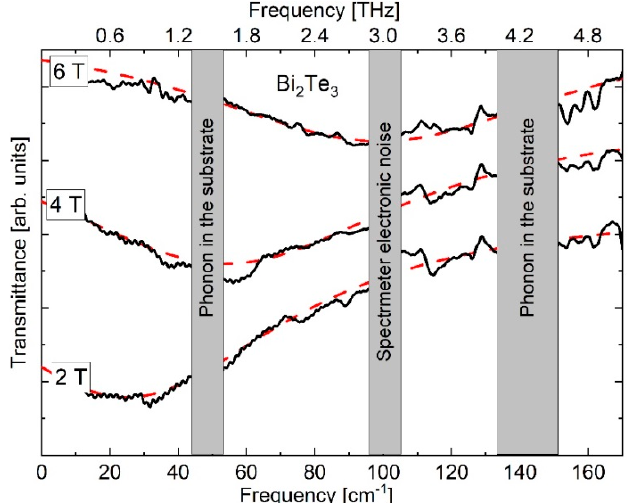
Figure 3. Examples of Lorentzian fits of the transmission spectra from Figure 1 for a few magnetic- field strengths as indicated. The raw experimental data are smoothed, using a Savitzki–Golay method [23]. Note that the spectra for 4 and 6 T are shifted upwards for clarity.